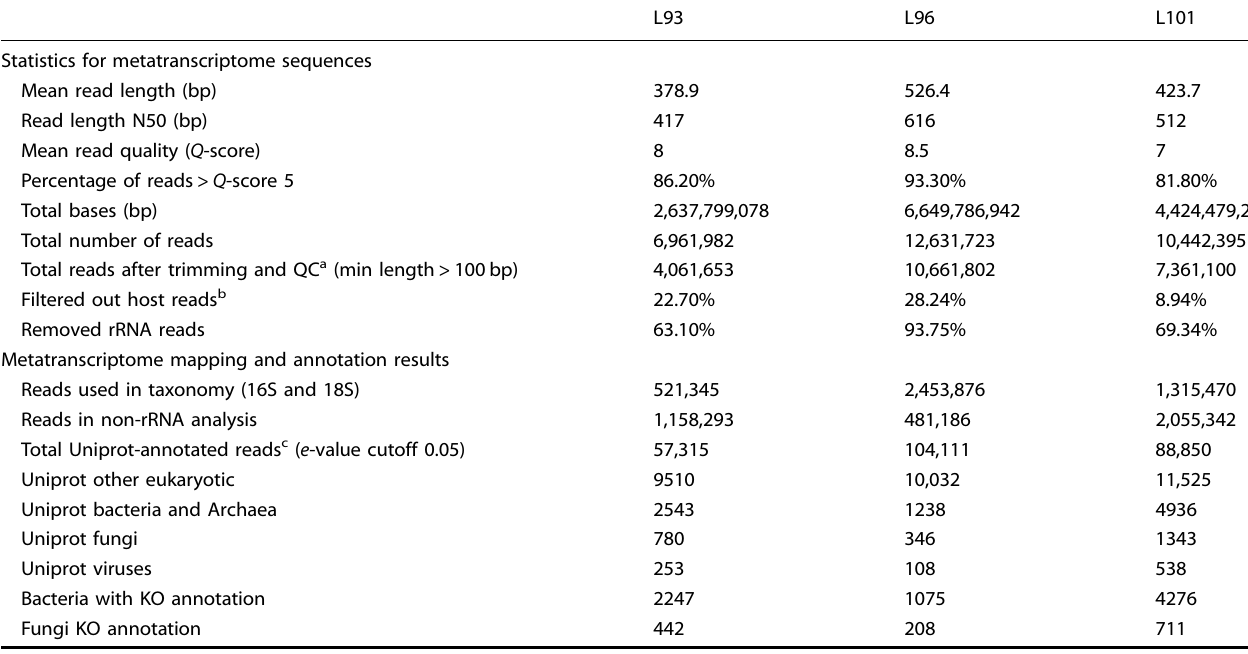
Table 1. Summary statistics for metatranscriptome nanopore sequencing, mapping, and annotation for each